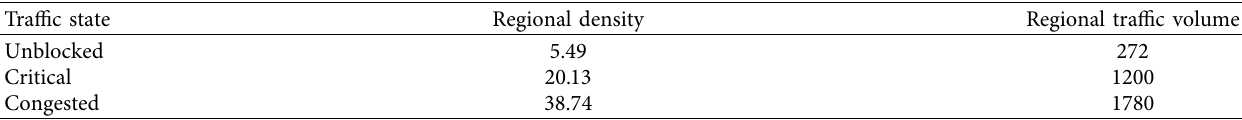
Figure 7: The traffic state classification results for subarea 1. Table 2: The clustering centers.